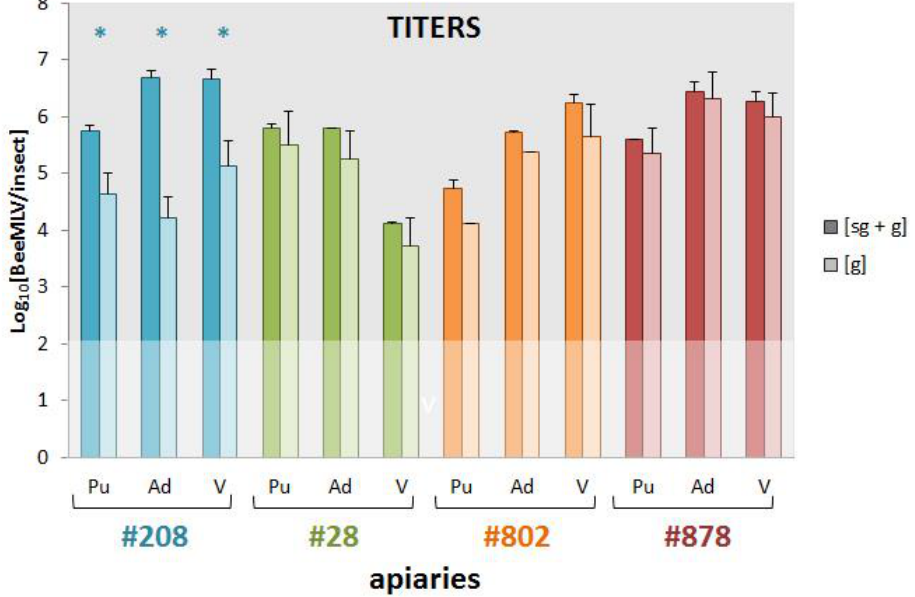
Figure 4. Log [BeeMLV] titers of genomic (g) and sub-genomic plus genomic (sg + g) 10 BeeMLV RNA in pupae (Pu), adults (Ad) and varroa (V) samples collected in Autumn 2002 from four apiaries in Western (#208; blue), Northern (#28; green) Eastern (#802; orange) and Southern (#878; red) France. Values represent the mean and standard deviation of two independent assays for only genomic RNA, and two assays for genomic-plus-subgenomic RNA (located 5′ and 3′ respectively of the putative start of the sub-genomic RNA; Figure 1), run on the pooled cDNA from 10 colonies in each apiary, for each of the sample types. The faded area represents the limit of detection. Significant differences between the genomic and genomic-plus-subgenomic titers, as determined by t -tests, are marked by an asterisk (*).